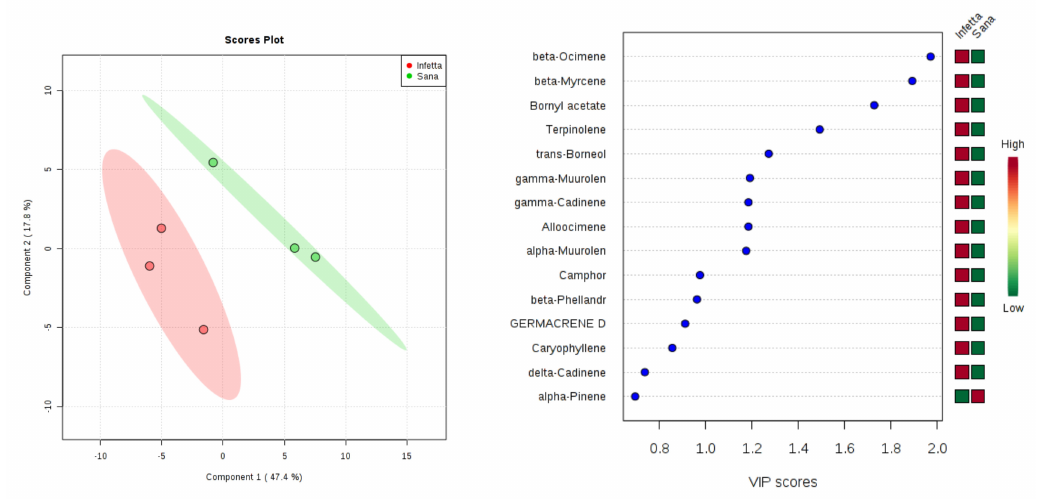
Figure 4. Partial least squares discriminant analysis applied to the volatiles emitted from pine needles collected upon the Sampling #1 (NEST)in Bova. Symbols as in Figure 3.